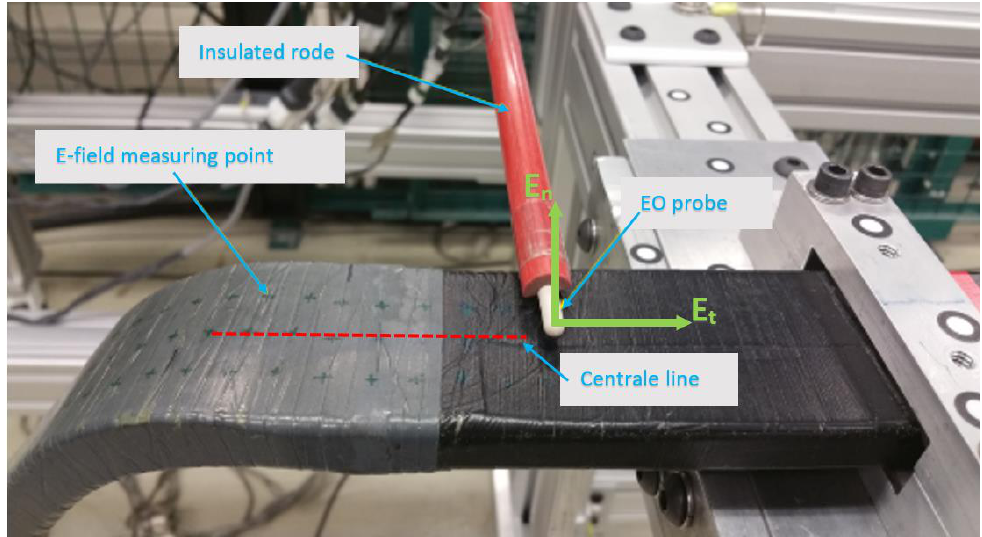
Figure 5. Closed view of the EO probe at the surface of the stress grading system with the referenced measuring points and E-field component orientation.